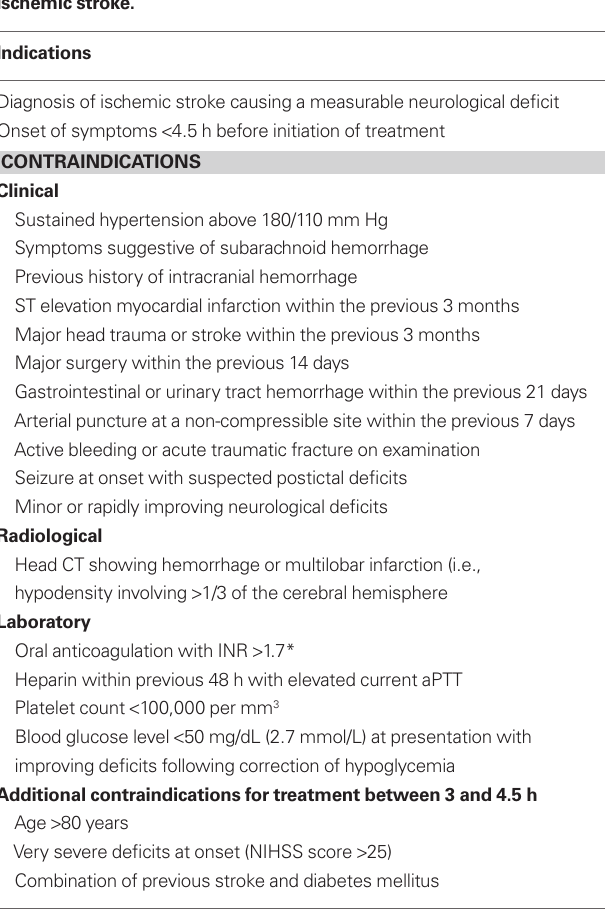
Table 2 | Indications and contraindications for intravenous rt-PA in acute ischemic